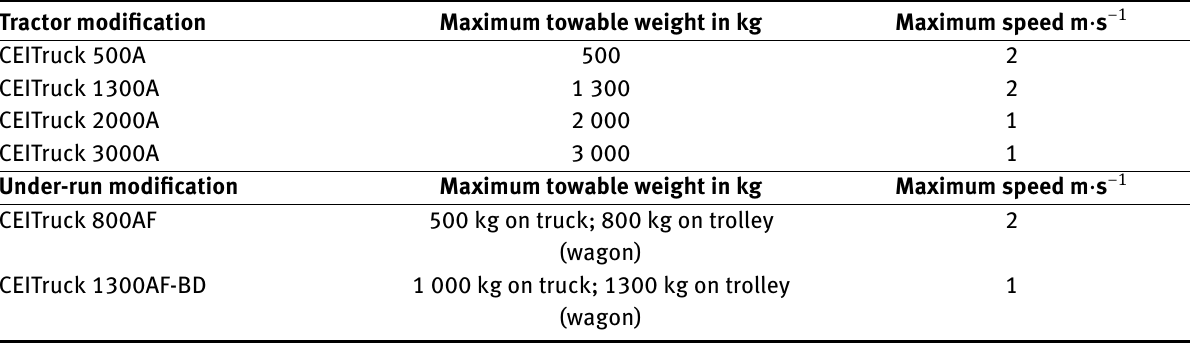
Table 2: Selected technical parameters of AGV CEITruck [23].